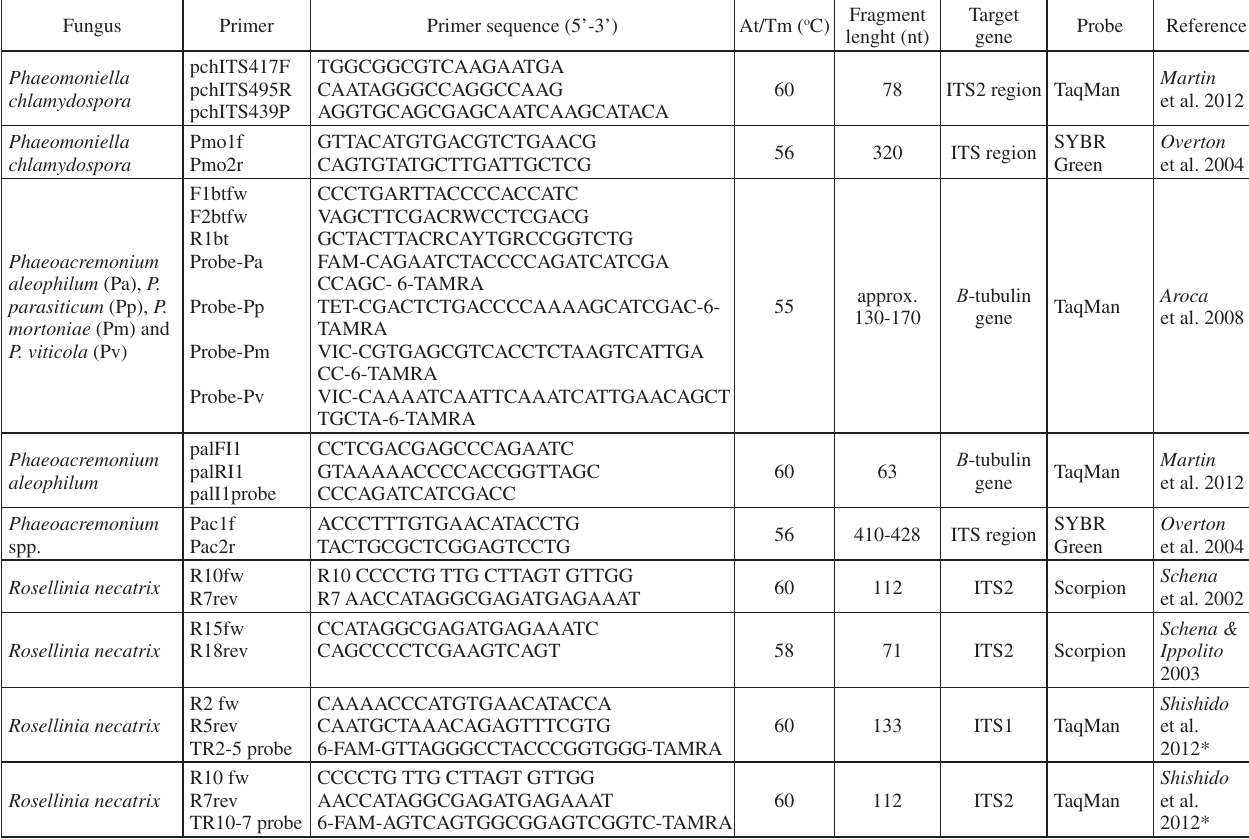
Table 5. Fungus specific